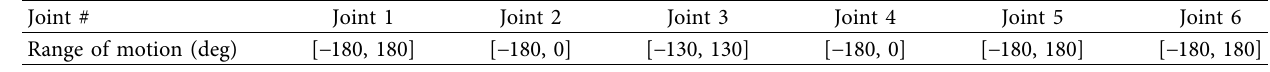
Table 1: Rotation angle range of each joint in the selected robot workspace.